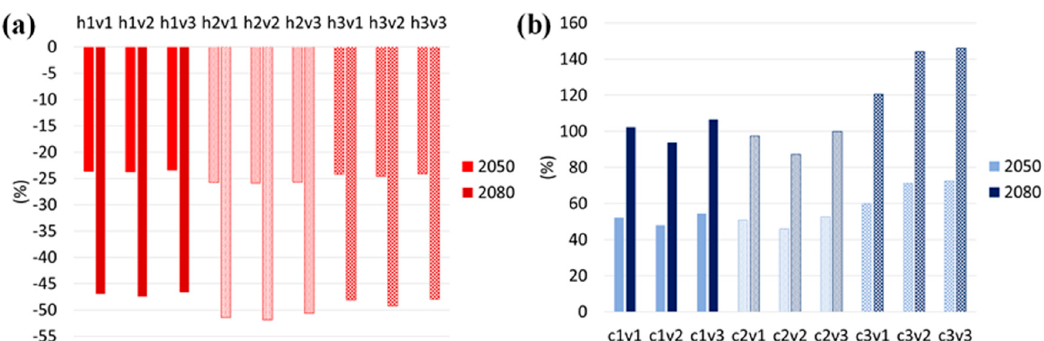
Figure 8. Relative differences between the energy needs calculated in the current climate and in future climate scenarios for: ( a ) the heating season; ( b ) the cooling season.